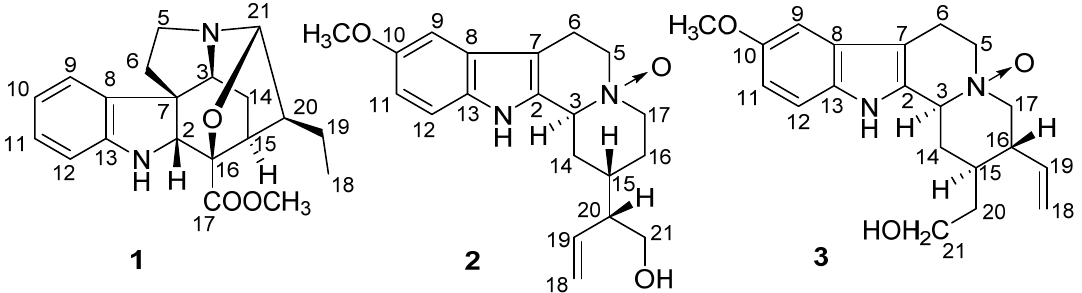
Figure 1. Chemical structures of compounds 1 – 3.